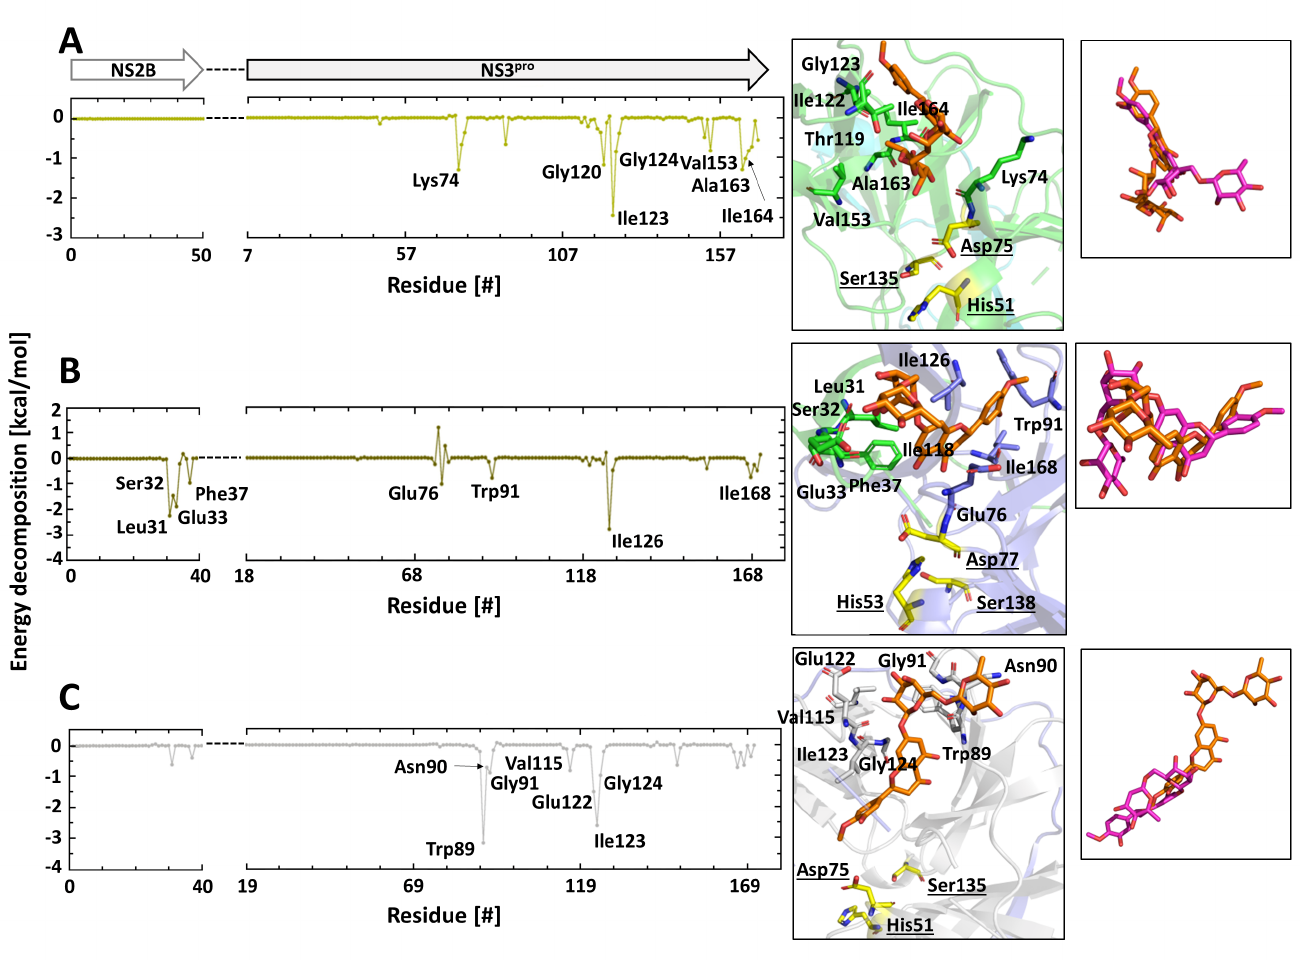
Figure 6. Amino acids contributing to the DENV2, YFV, and WNV NS2B/NS3 pro –HSD interaction. The decomposition energies of amino acids that participated in the interaction with HSD are based on the MD simulations. Coordination of HSD in the protease binding region and overlay of the HSD replicas 1 and 2; ( A ) DENV2 NS2B/NS3 pro –HSD interaction; ( B ) YFV NS2B/NS3 pro –HSD interaction; ( C ) WNV NS2B/NS3 pro –HSD interaction. Amino acid residues with an energy decomposition < − 1 kcal/mol are